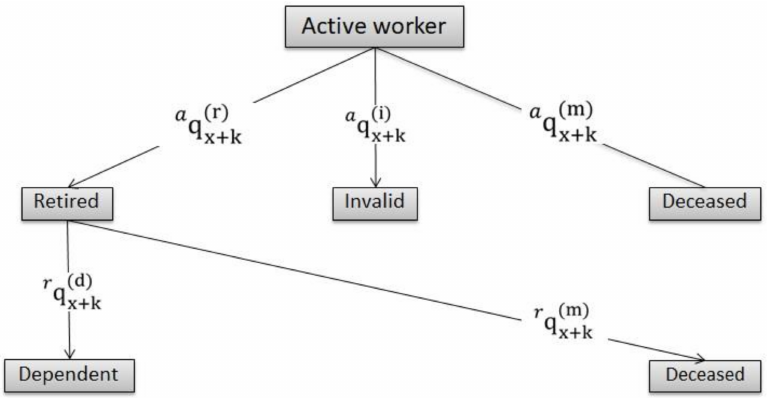
Figure 1. Transition probabilities. Source: Own